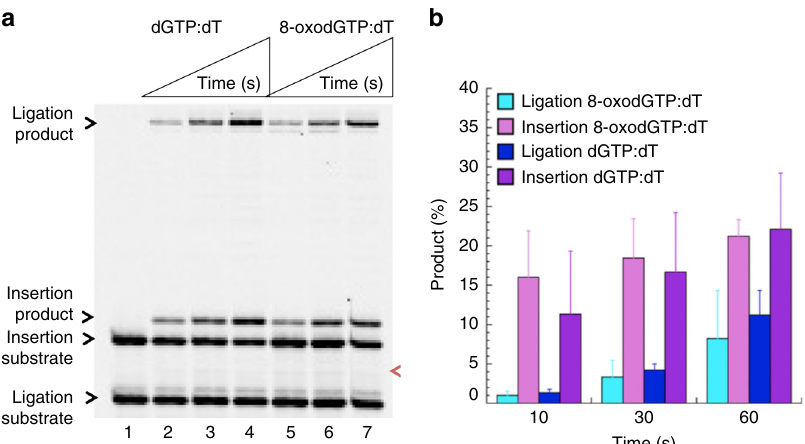
Fig. 1 Pol µ dGMP and 8-oxodGMP insertion coupled with ligation. a Lane 1 is the minus enzyme control for the single-nucleotide gapped DNA substrate with template base T. Lanes 2 – 4 and 5 – 7 are the reaction products in the presence of dGTP and 8-oxodGTP, respectively, and correspond to time points of 10, 30, and 60 s. The position of 5 ′ -adenylate product is indicated as magenta arrow. b Graph shows time-dependent changes in the products of insertion (pink and purple for 8-oxodGTP and dGTP insertions, respectively) and ligation (cyan and blue for ligation following insertion of 8-oxodGTP and dGTP, respectively). The data represent the average of four independent experiments ± SD. Corresponding uncropped gel image and presentation of the data in line graph format are shown in Supplementary Fig. 2